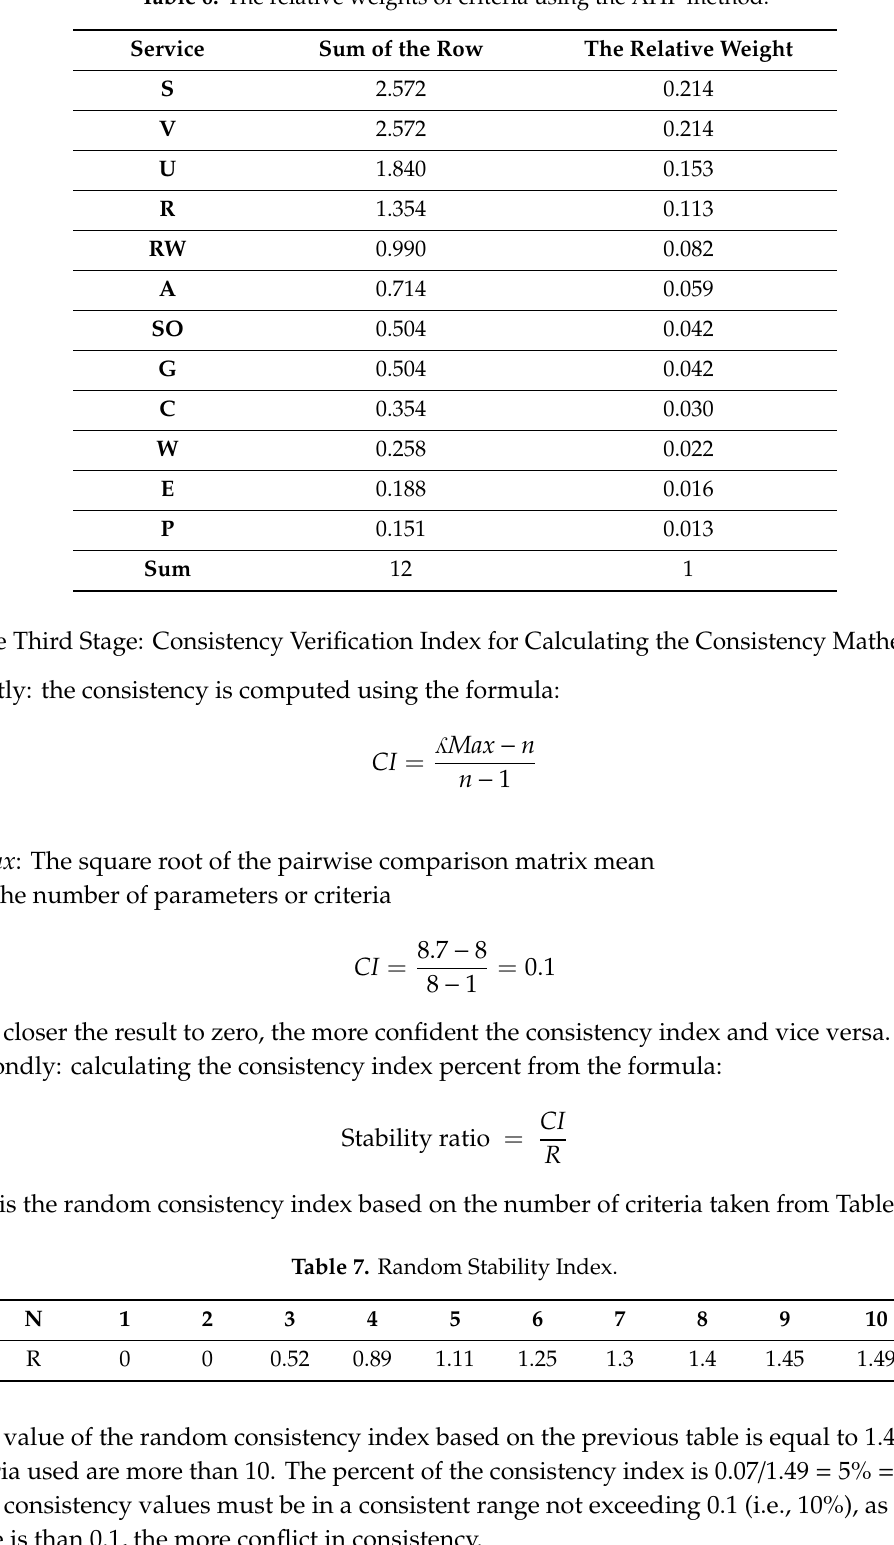
Table 6. The relative weights of criteria using the AHP method.